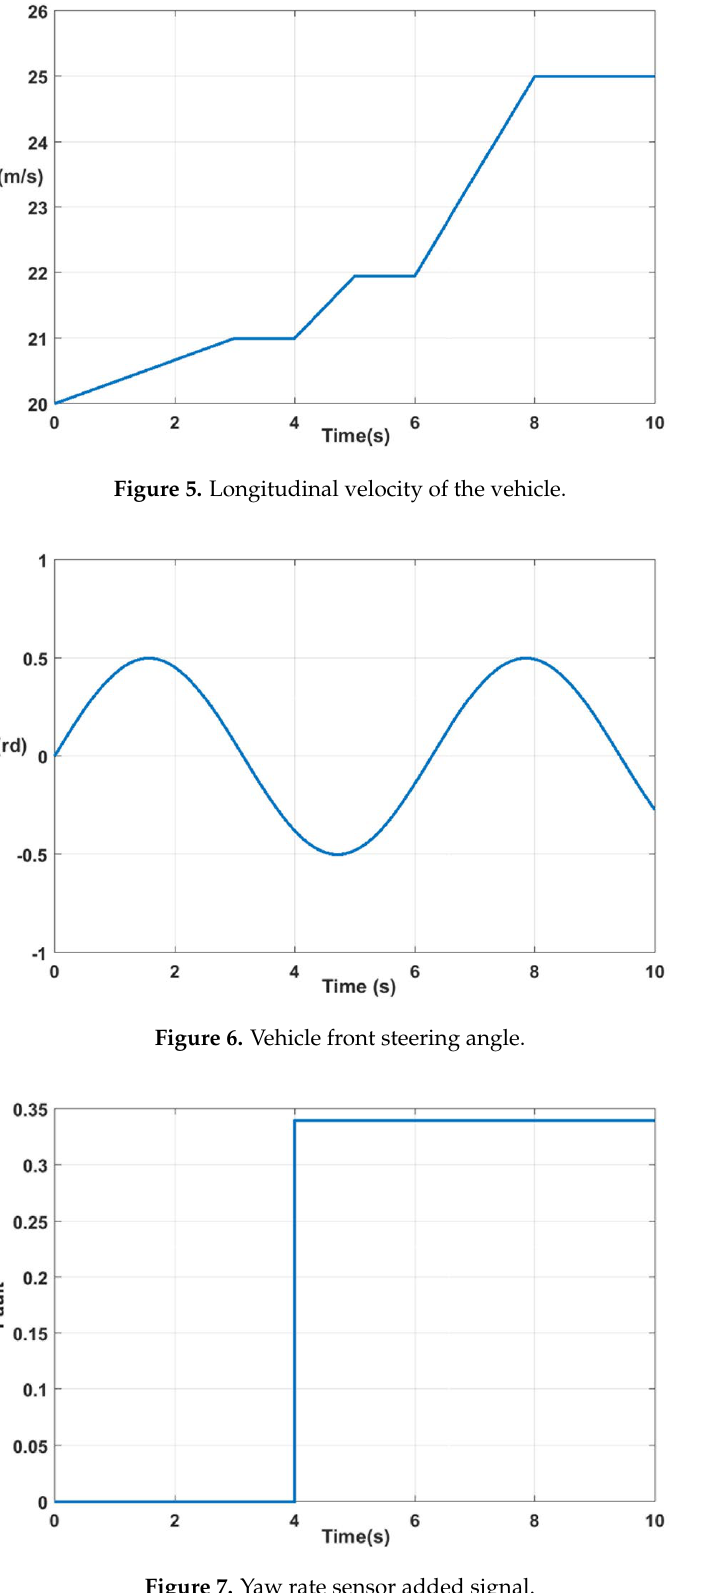
Figure 7. Yaw rate sensor added